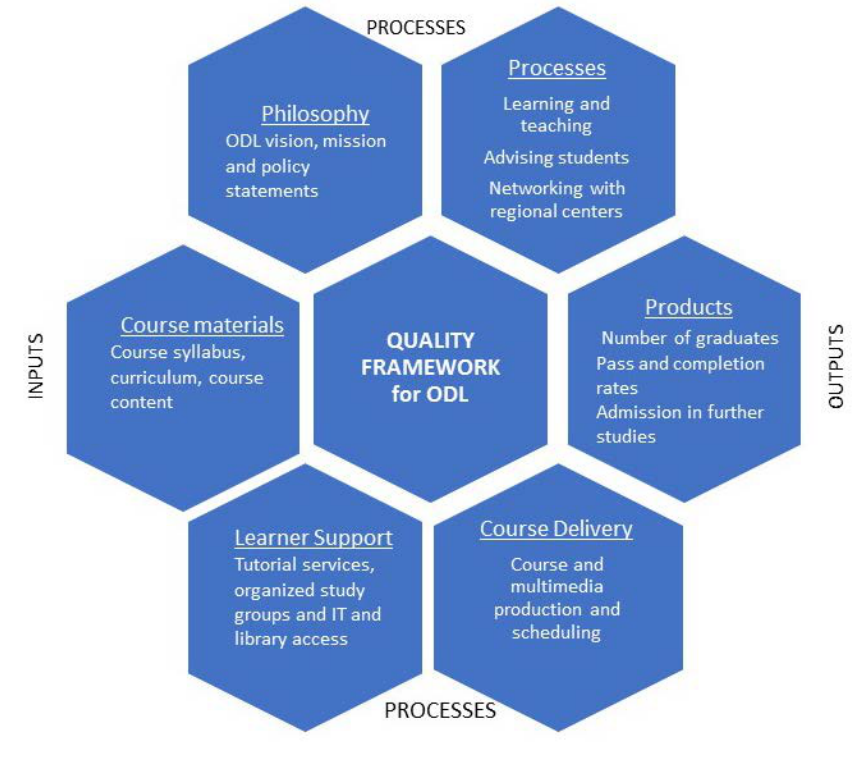
Figure 1. Quality assurance framework for ODL. Adapted from Quality assurance in open and distance learning: Trainers’ kit 005 (p. 82) , by COL & ADB, 1999, Vancouver: COL. Copyright 1999 by Commonwealth of